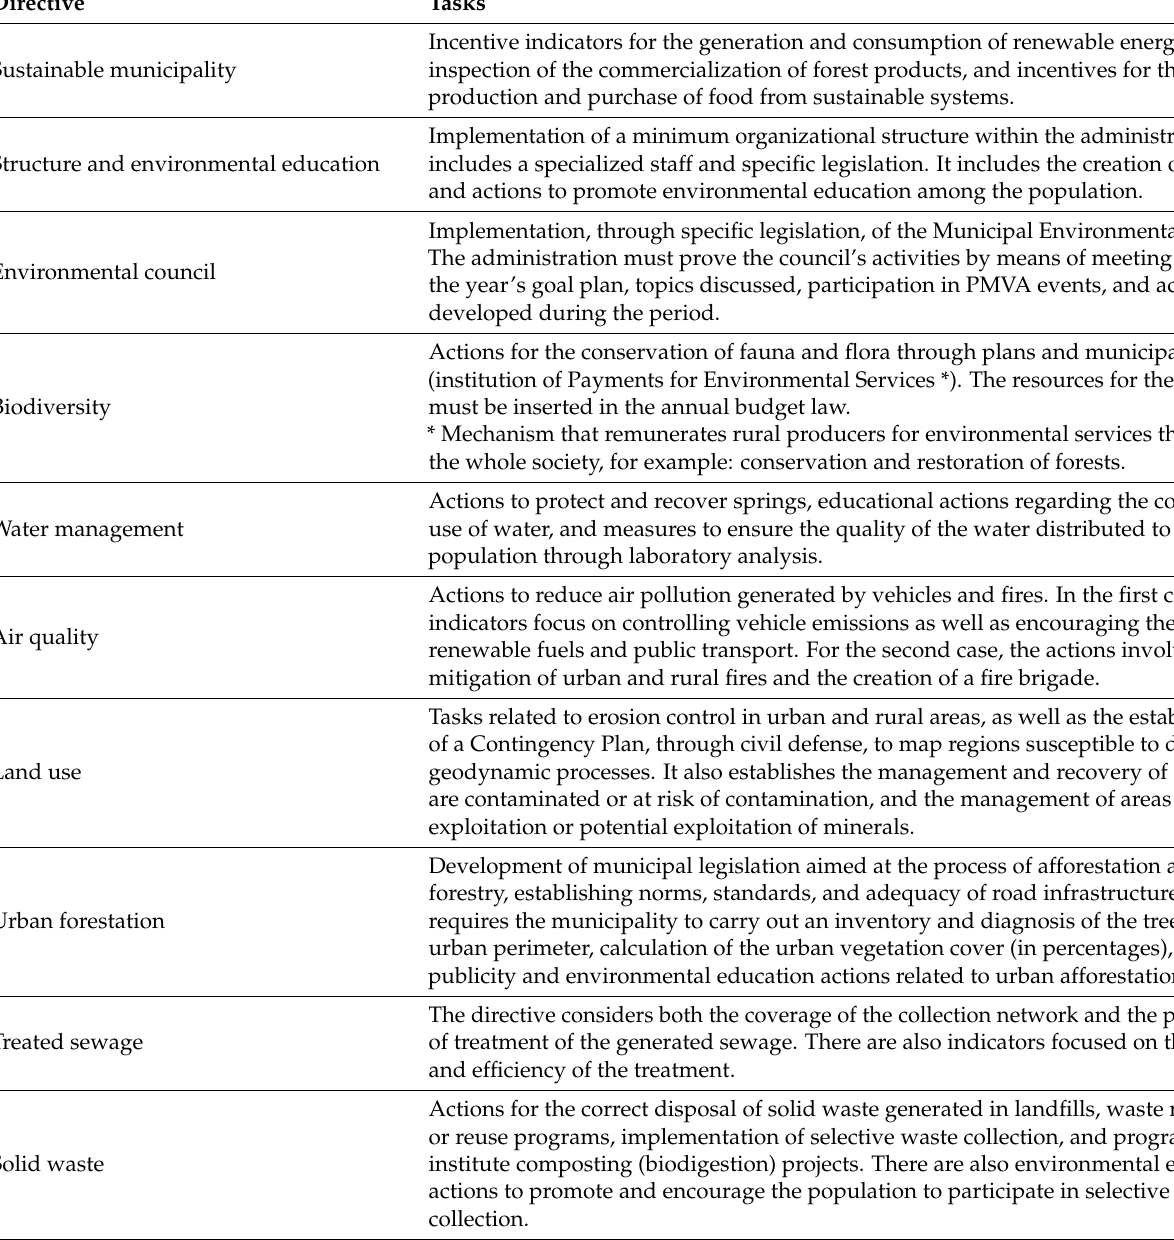
Table 1. Description of the PMVA